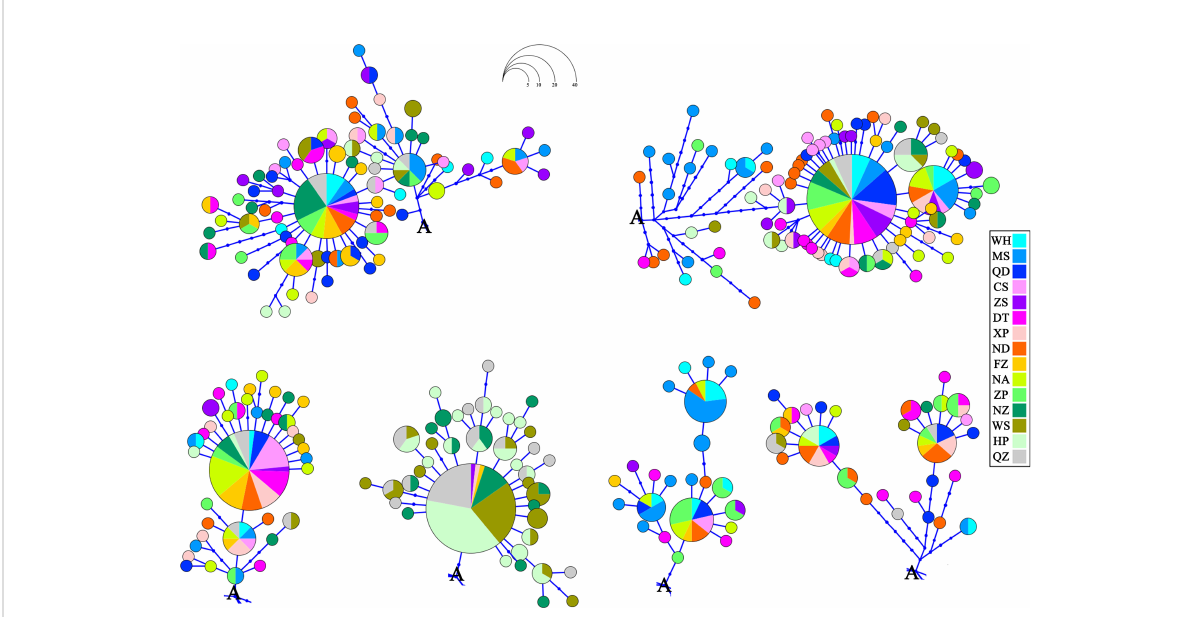
FIGURE 2 Haplotype network showing the haplotype connections and geographical frequency of occurrence for Sebastiscus marmoratus . Occurrences of the letter A in the fi gure denote the common